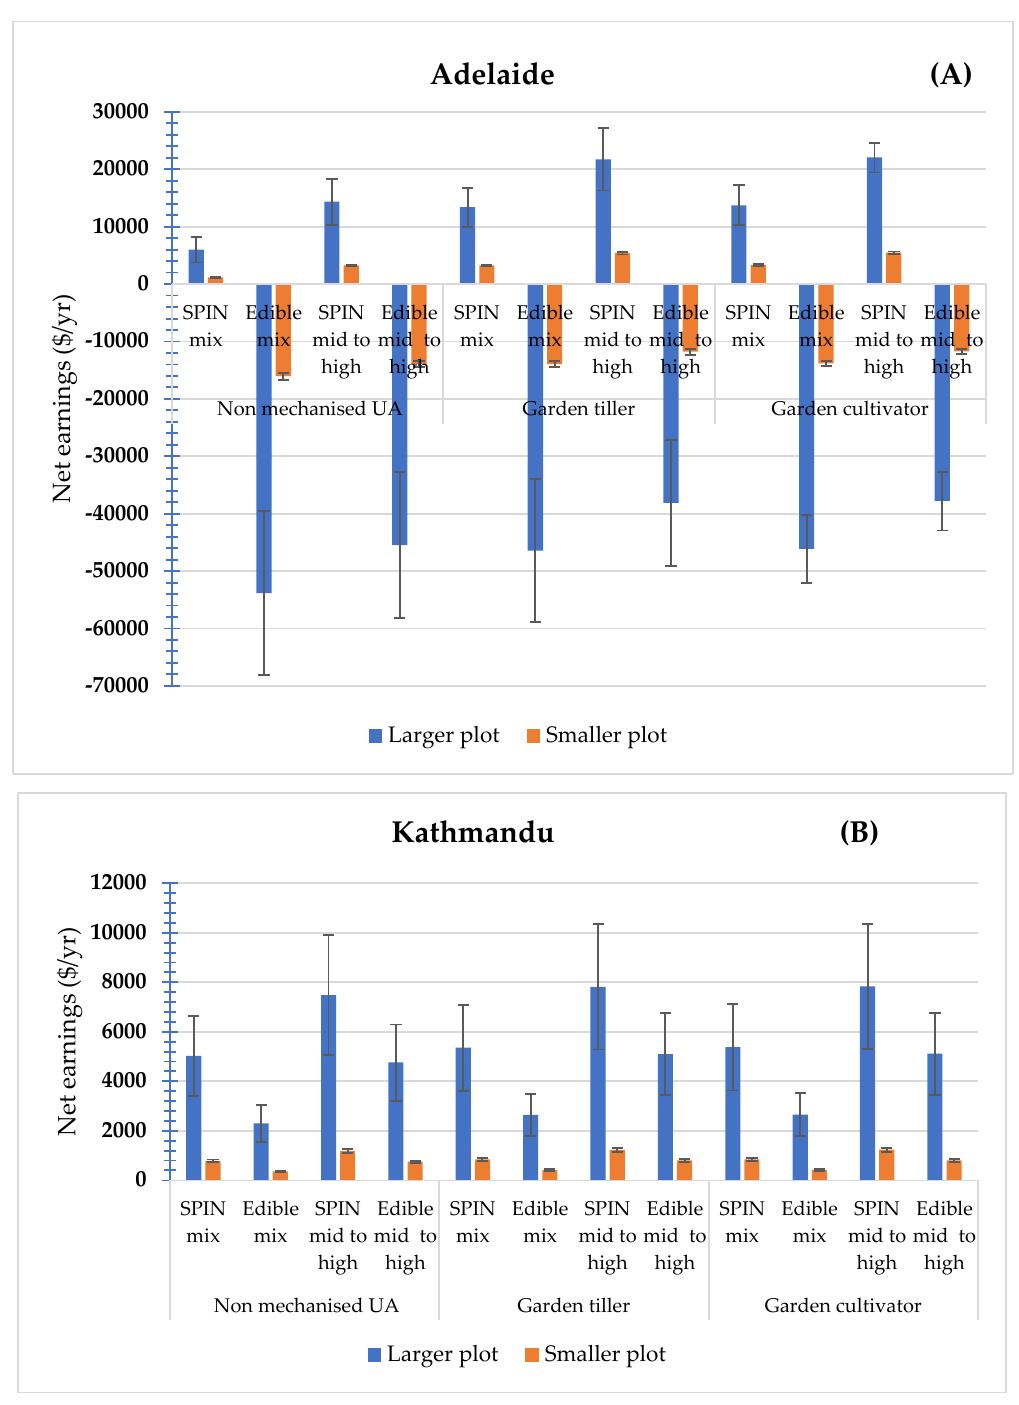
Figure 5. ( A,B ). Net earnings calculation in Adelaide and Kathmandu Valley. The I marker represents the standard error of the mean.